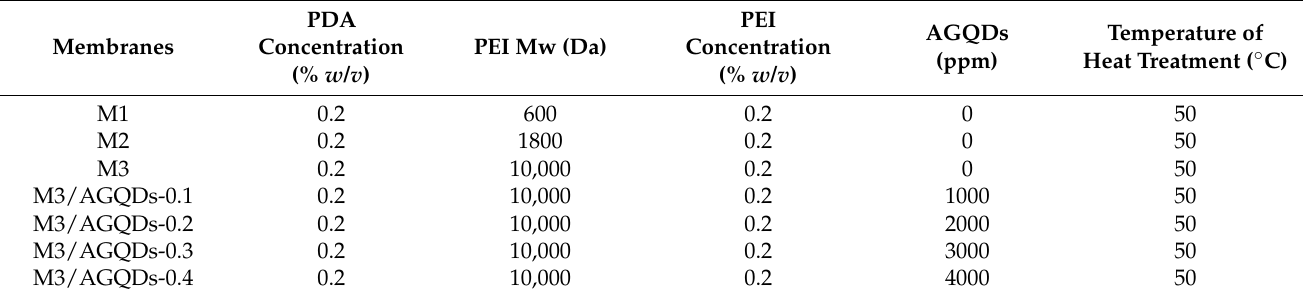
Table 1. The co-deposition reaction conditions of TFC and TFN NF membranes.